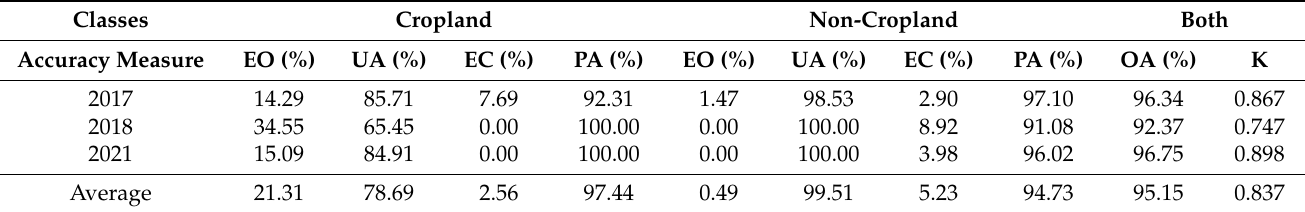
Table 2. Results of the accuracy assessment for the binary cropland classification in 2017, 2018, and 2021 1 .